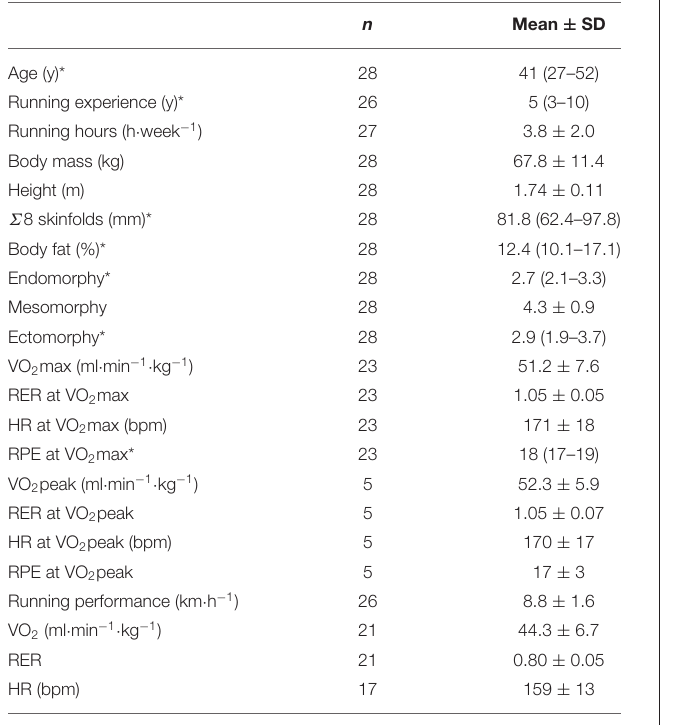
TABLE 1 | Participant